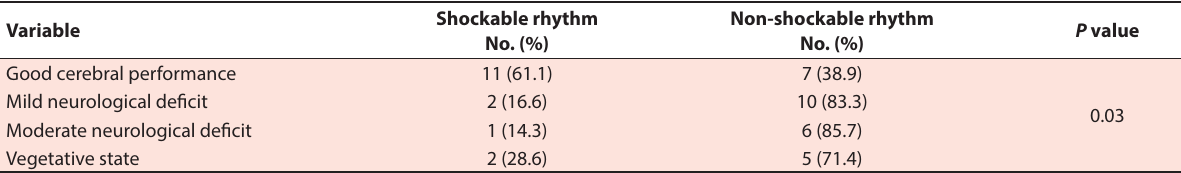
Shockable rhythm No. (%)